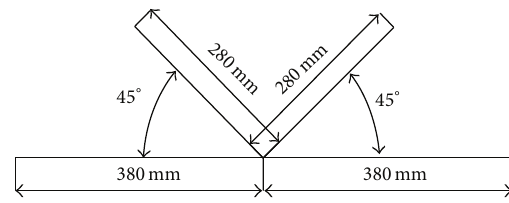
Figure 3: The coordinates of internal cell.